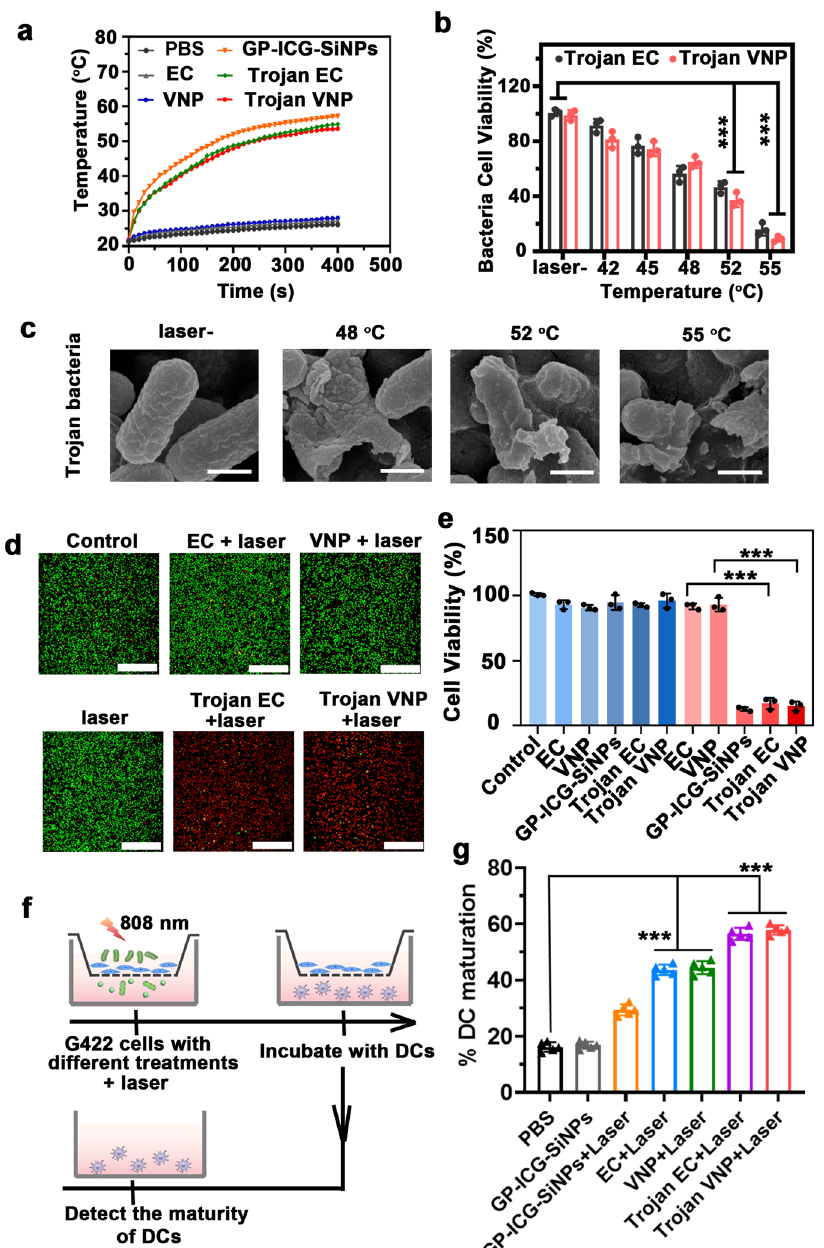
Fig. 3 | Trojan bacteria system against tumor in vitro. a Photothermal heating curves of PBS, GP-ICG-SiNPs, EC, VNP, Trojan EC, and Trojan VNP under the irradiation of NIR laser (808nm, 1.2W/cm 2 ). b The viability of Trojan EC or Trojan at different temperatures (mean±SD, n =3). *** p =6.27×10 − 6 for laser- vs. 52°C, *** p =3.90×10 − 7 for laser- vs. 55°C (Trojan EC); *** p =2.57×10 − 6 for laser-vs.52°C,*** p =2.29×10 − 7 forlaser-vs.55°C(TrojanVNP). c SEMimagesof Trojan bacteria at different temperatures. Scale bars: 200nm. All imaging experiments were repeated three times with similar results. d Confocal fl uor- escenceimagesofG422cellsstainedwith calcein-AM(CAM)andPIaftertreated with PBS, EC, VNP, GP-ICG-SiNPs, Trojan EC, and Trojan VNP with or